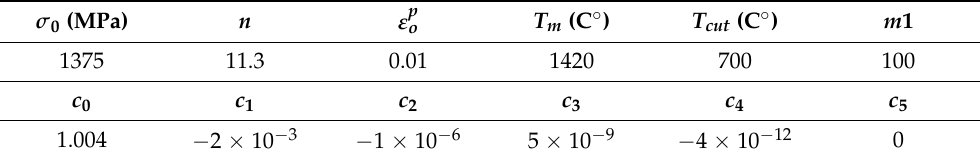
Table 2. Inconel 718 power law-based material parameters used in the FE model.